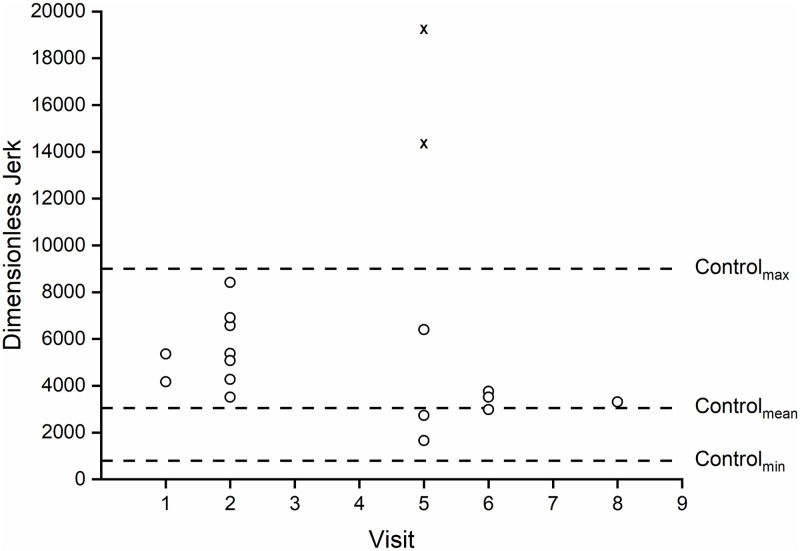
Dimensionless jerk values for drinking task trials.Dimensionless jerk values for drinking task trials for the mainparticipant across practice (smaller jerk values indicate smoothermovements). Jerk values denoted with a “x” were those in which themain participant had significant distractions or poor IMU alignmentwhich led to large jerk values. Additionally, trial #15, whichoccurred during visit 6, is omitted due to data corruption.